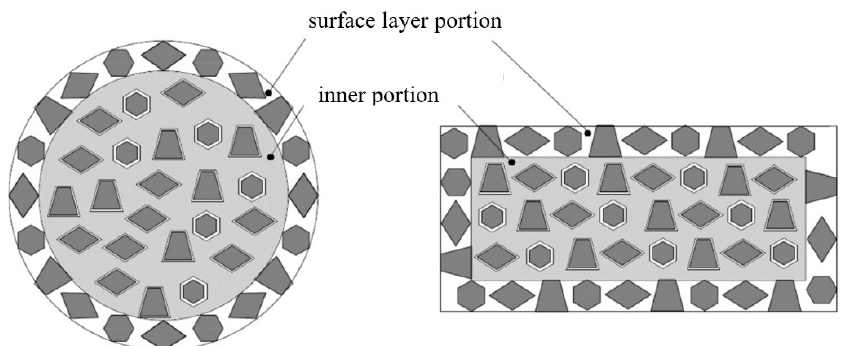
Figure 2. Surface layer and inner portions in a specimen section.